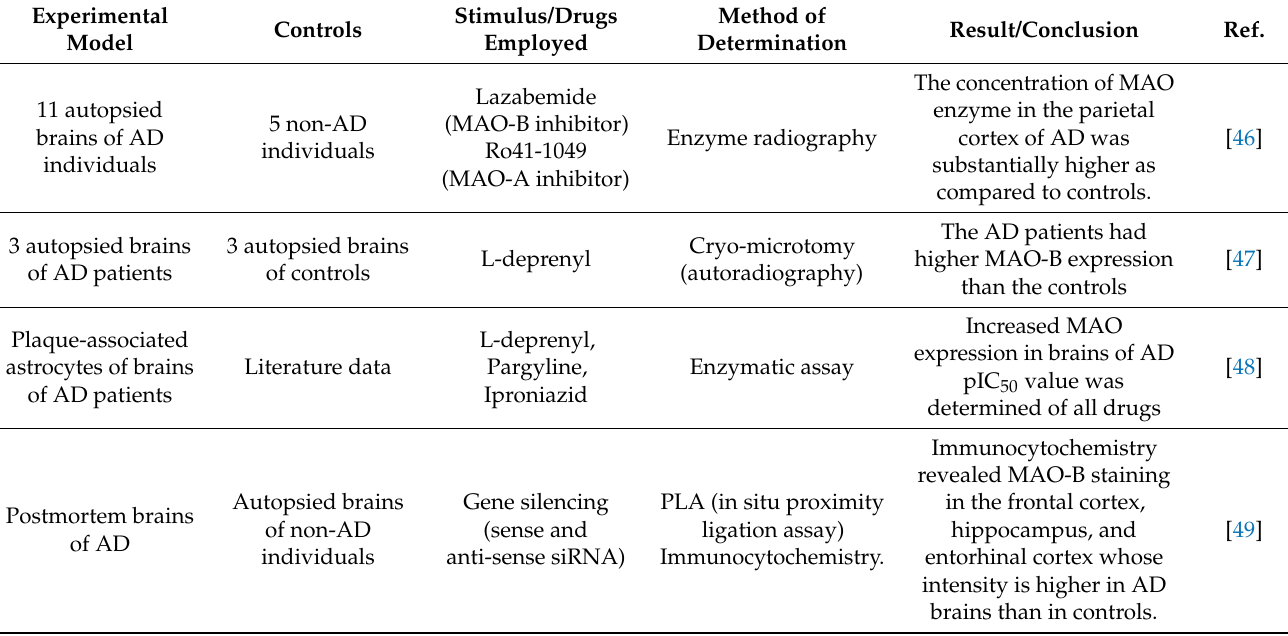
Table 1. Pre-clinical and clinical evidence suggesting monoamine oxidase association with progression of Alzheimer’s disease. Experimental Stimulus/Drugs Method of Controls Result/Conclusion Model Employed Determination